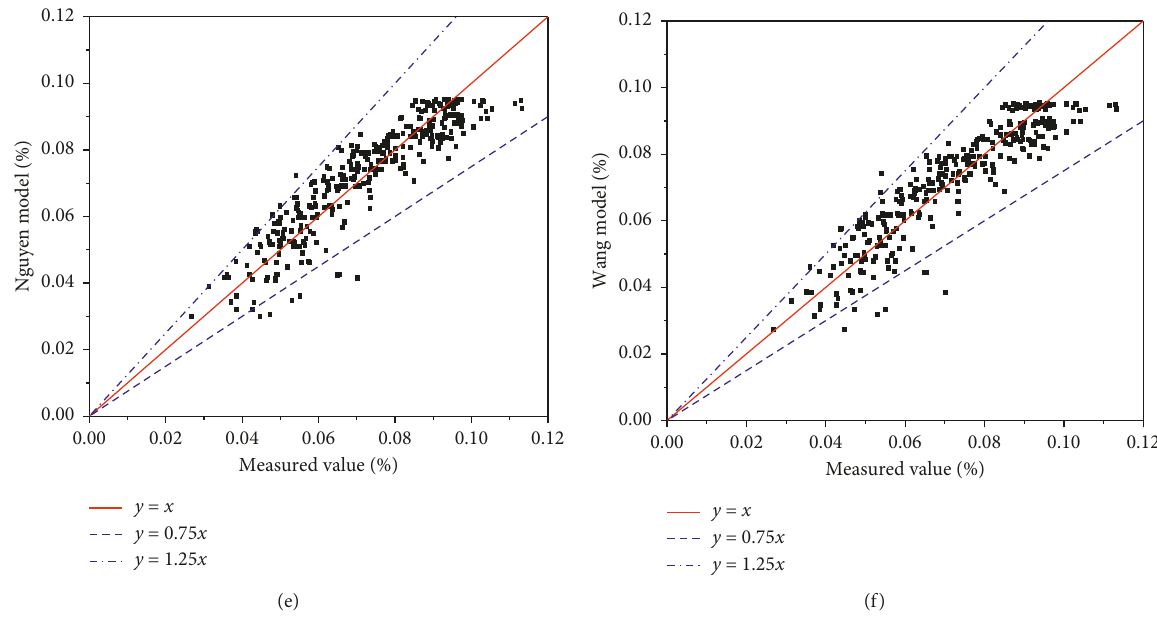
Figure 4: Comparison of the chloride content at different depths between model calculation and field measurement data. (a) Collepardi model. (b) Life-365 model. (c) DuraCrete model. (d) Ababneh model. (e) Nguyen model. (f) Wang